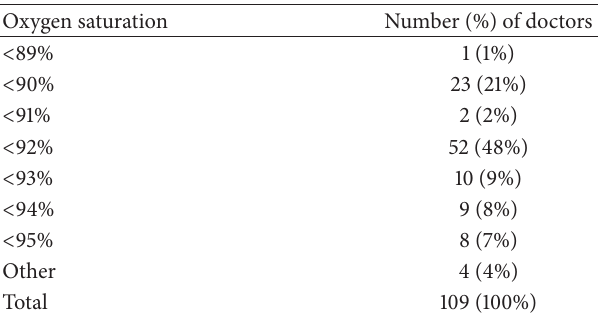
Table 1: The number (%) of doctors who administer supplemental oxygen at the given level of oxygen